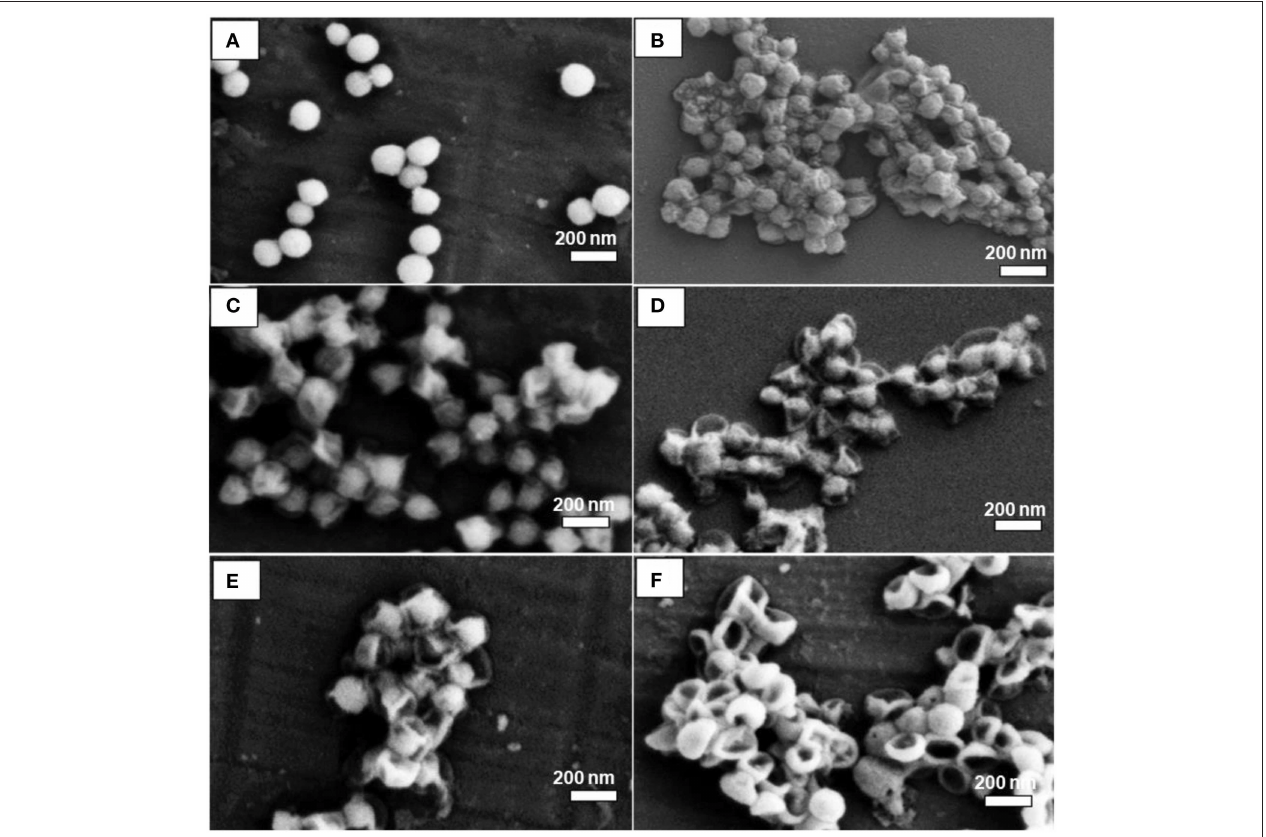
FIGURE 6 | SEM images of MSN@PDA with PDA thickness of 68nm after being dispersed in water at three different ratios: 1:1 (A,B) , 1:5 (C,D) , and 1:10 (E,F) after 24h (A,C,D), and 48h (B,D,F) , respectively.